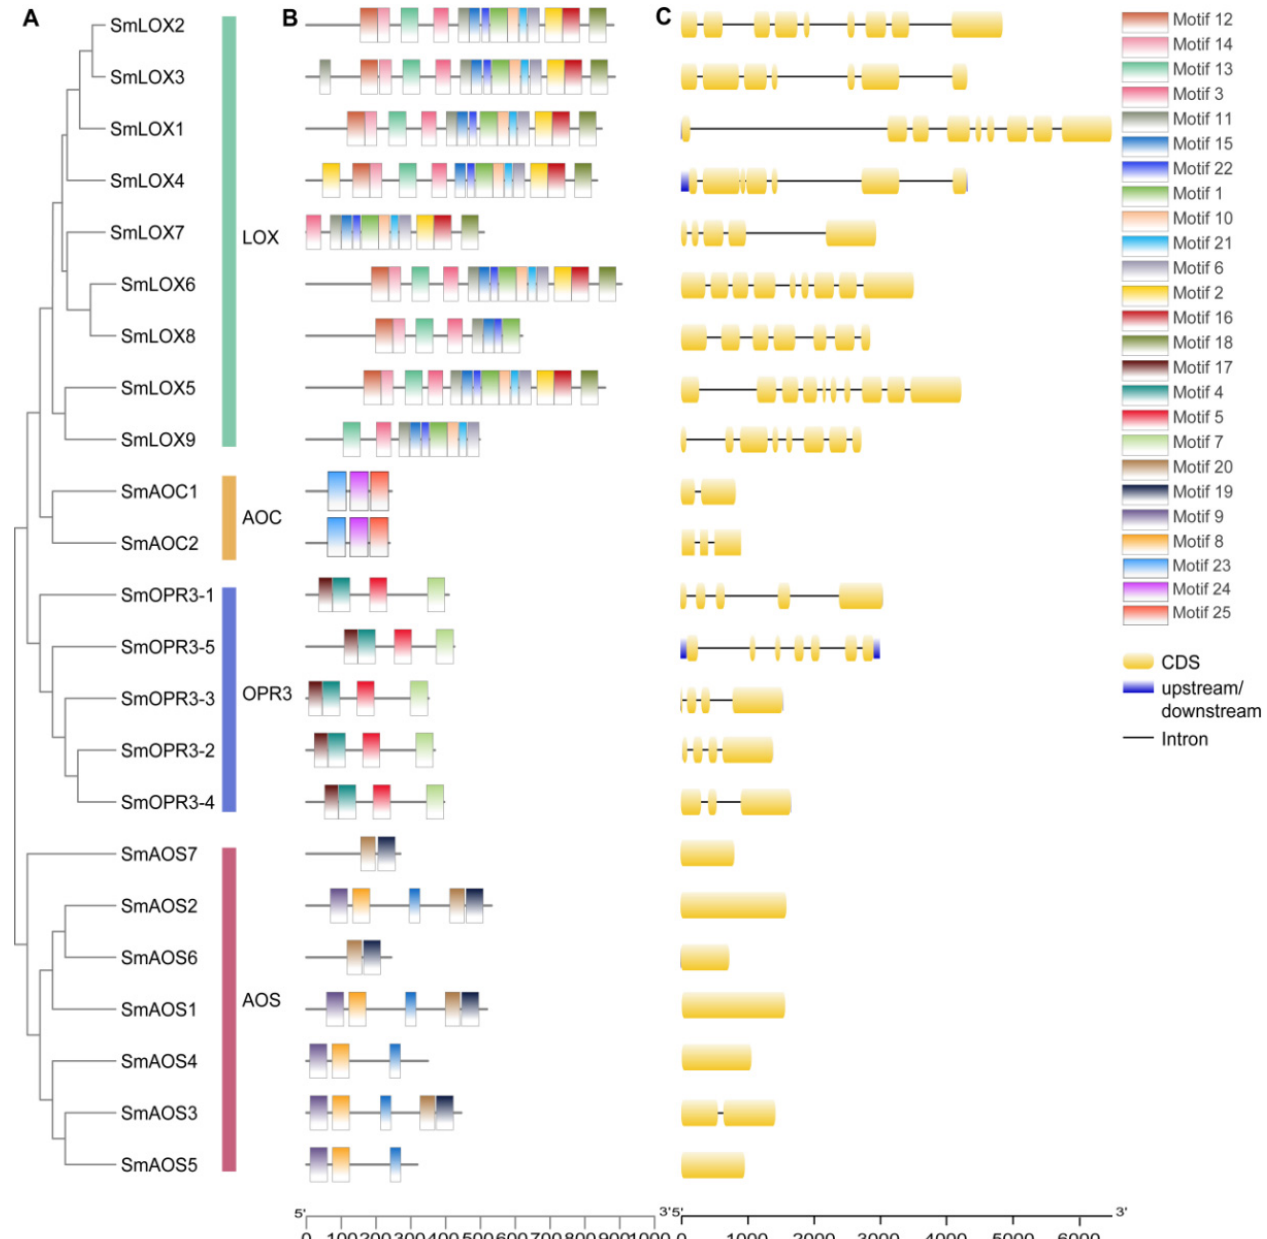
Figure 3. Phylogenetic relationships, gene structures, and conserved motifs of genes related to the JA synthesis pathway in S. miltiorrhiza . ( A ) The phylogenetic tree on the left contains 23 enzyme gene proteins. ( B ) Motif patterns of 23 proteins, where each pattern is displayed in a different colored box. ( C ) Exon/intron structures of 23 enzyme genes. Yellow boxes represent exons, black lines represent introns, and blue boxes represent untranslated regions.